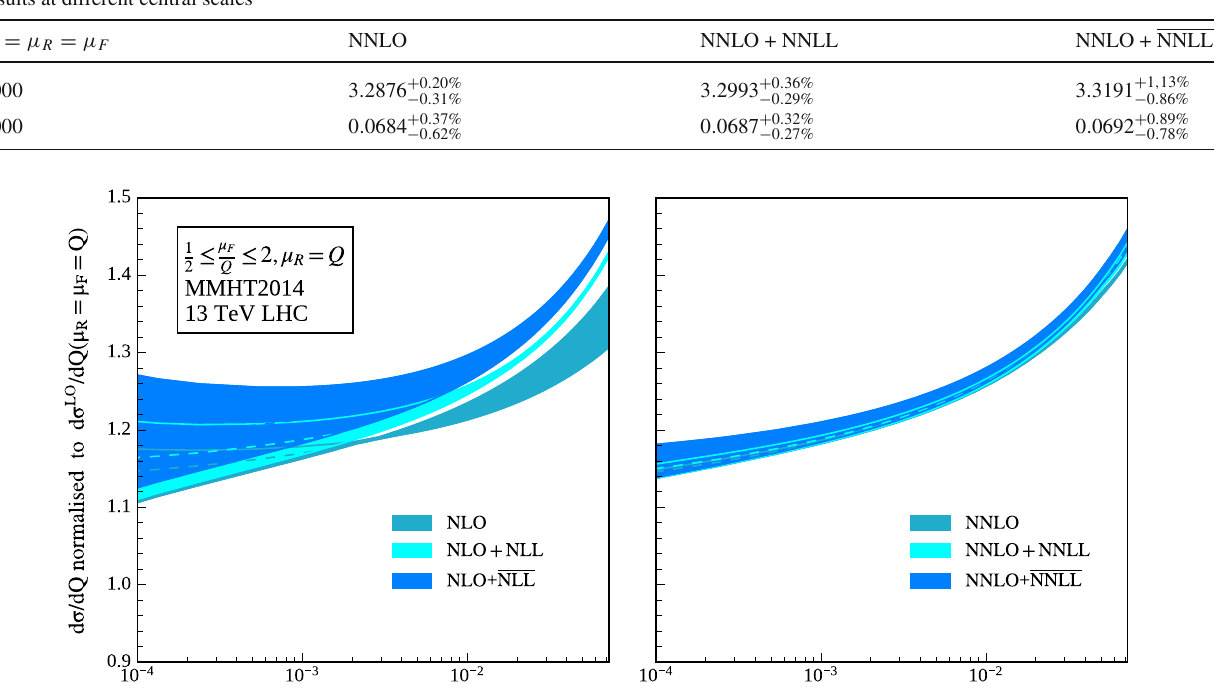
Fig. 10 7-point scale variations of NNLL and NNLL matched to NNLO for all-channels (left panel) and q ¯ q -channel (right panel) Table 9 Values of SV and SV + NSV resummed cross section in 10 − 5 pb/GeV at second logarithmic accuracy in comparison to the fixed-order results at different central scales